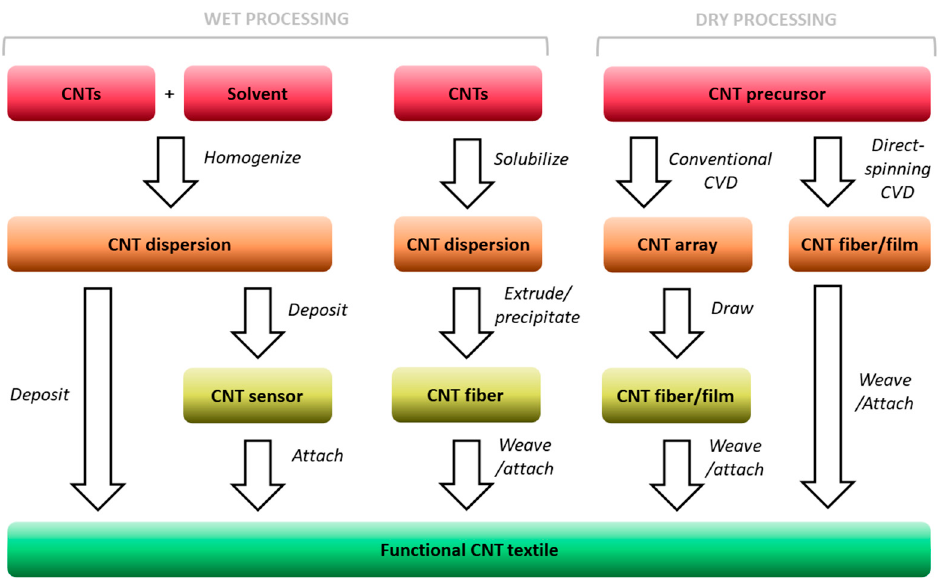
Figure 2. Main-stream routes of formation of functional CNT-based textiles for health monitoring. (e.g., sodium dodecylbenzene sulfonate [70], sodium cholate [71]), cationic (e.g., cetyltrimethy- lammonium bromide [72], dodecyltrimethylammonium bromide [73]), nonionic (e.g., Triton X-100 [74], Pluronic series [75]), or amphoteric (e.g., Amber 4001 [76], sodium